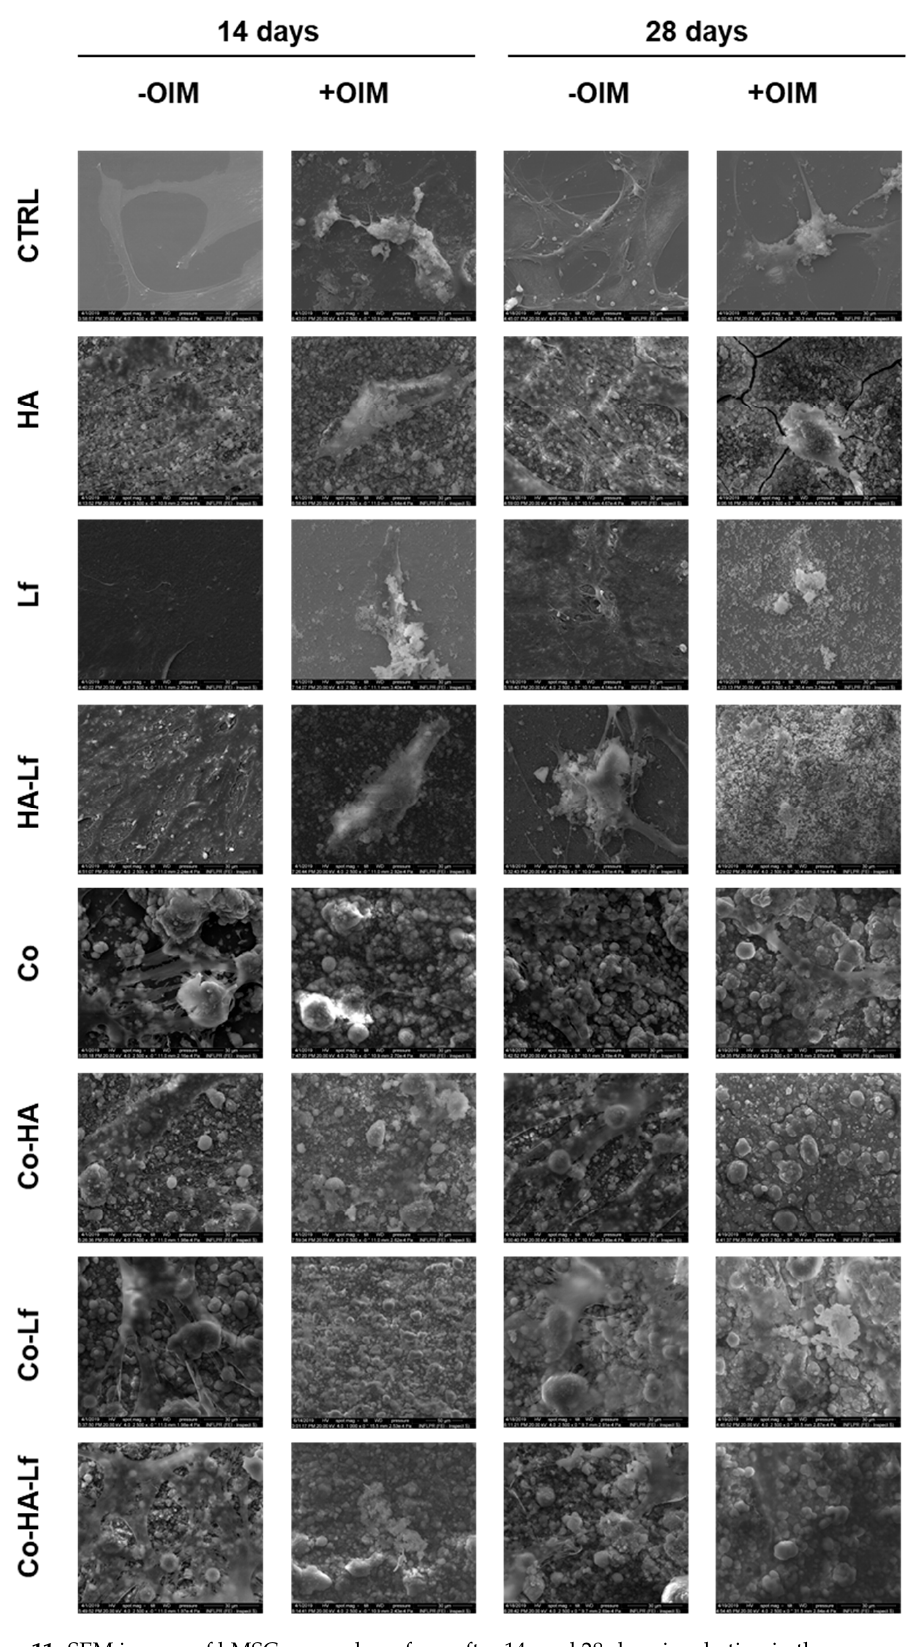
Figure 11. SEM images of hMSCs on each surface, after 14- and 28-days incubation in the presence and absence of the osteoinduction medium (magnification order 2500×—scale bar 30 μ